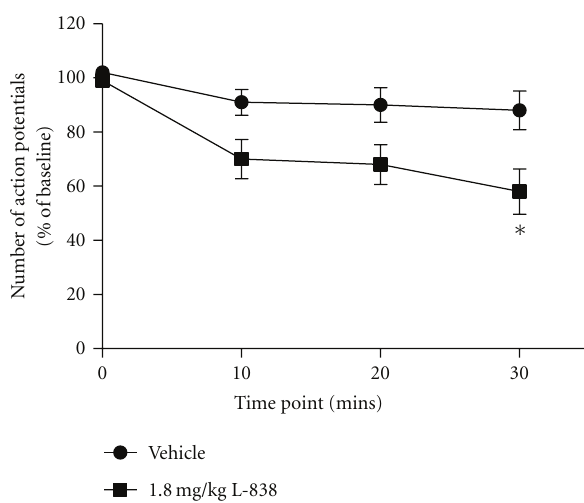
Figure 6: The e ff ects of L-838,417 on pinch-evoked wide dynamic range (WDR) neurone firing in the chronic constriction injured rat. Data are means ± sem. n = 6–8. ( ∗ = P < 0 . 05 compared to vehicle- treated group, t -test.)